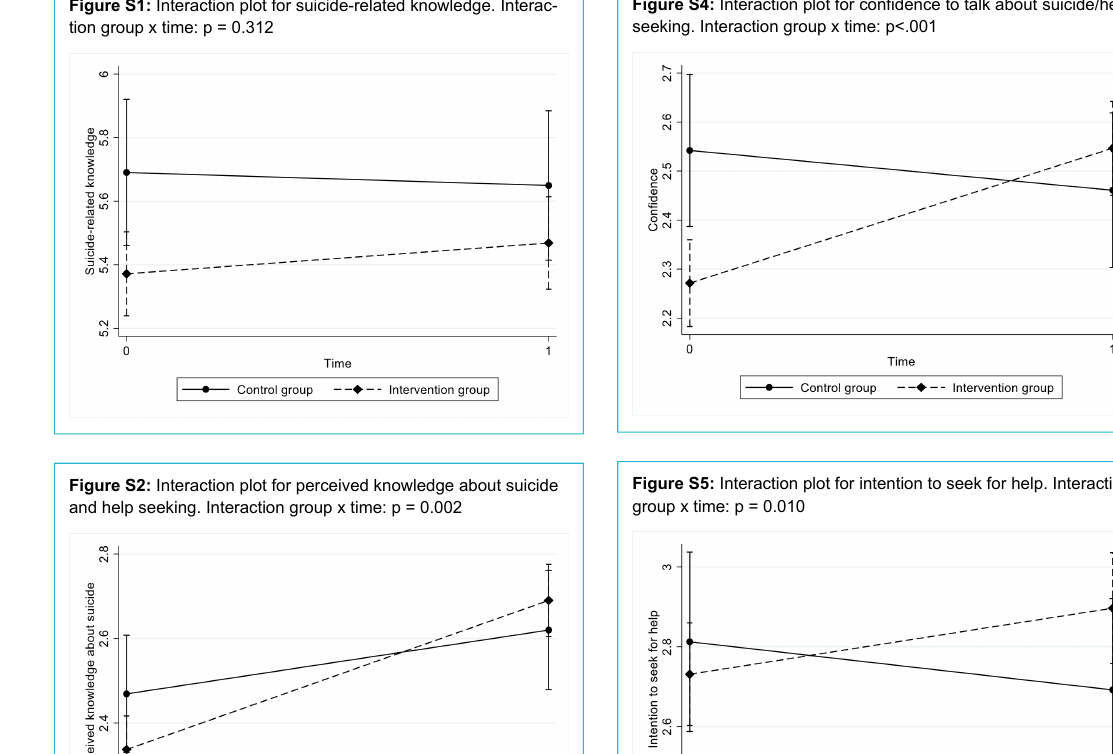
Figure S1: Interaction plot for suicide-related knowledge. Interac- tion group x time: p = 0.312